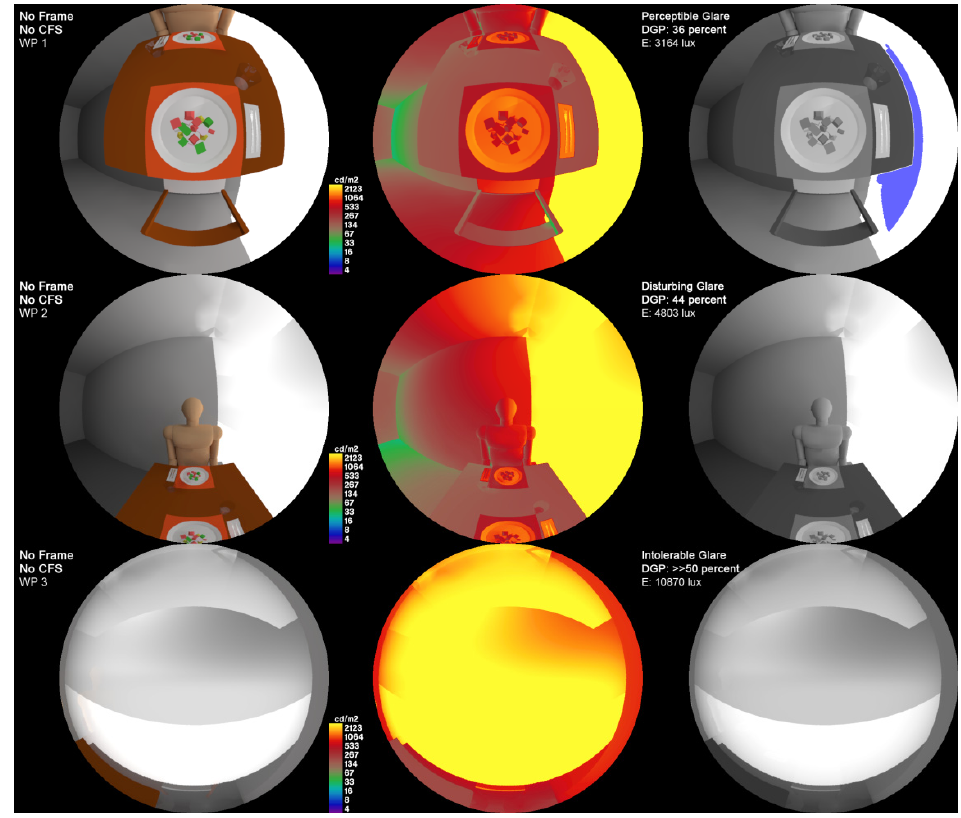
Figure 11. Visualization, false color image and glare source image with DGP value of highly glazed façade system from a point of view and the work plane, relation plane and out plane that contributes in this complete visual field.